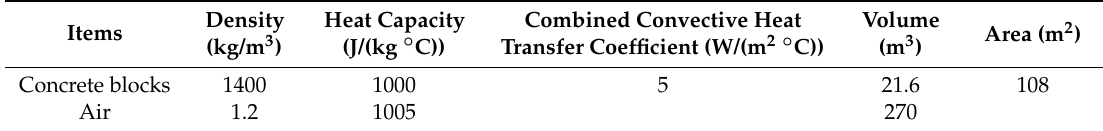
Table 1. A summary of physical parameters of the building envelope and air [26].